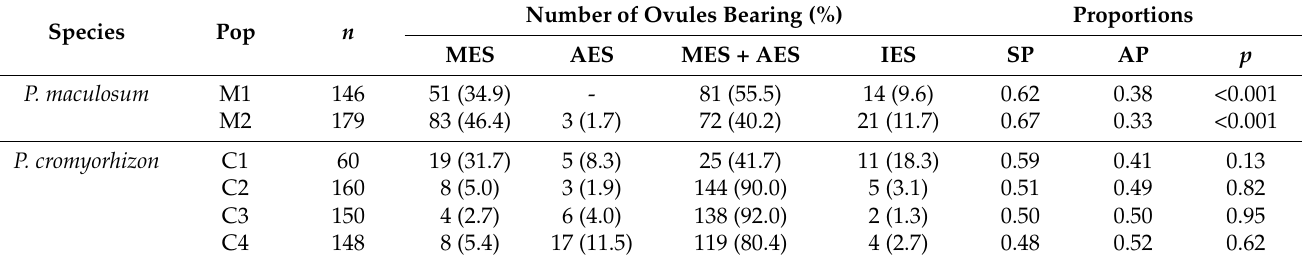
Table 1. Observed number and percentage (%) of embryo sac types in tetraploids of P. maculosum and P. cromyorhizon , and the observed proportions of the sexual (SP) and apomictic (AP) pathways at ovule